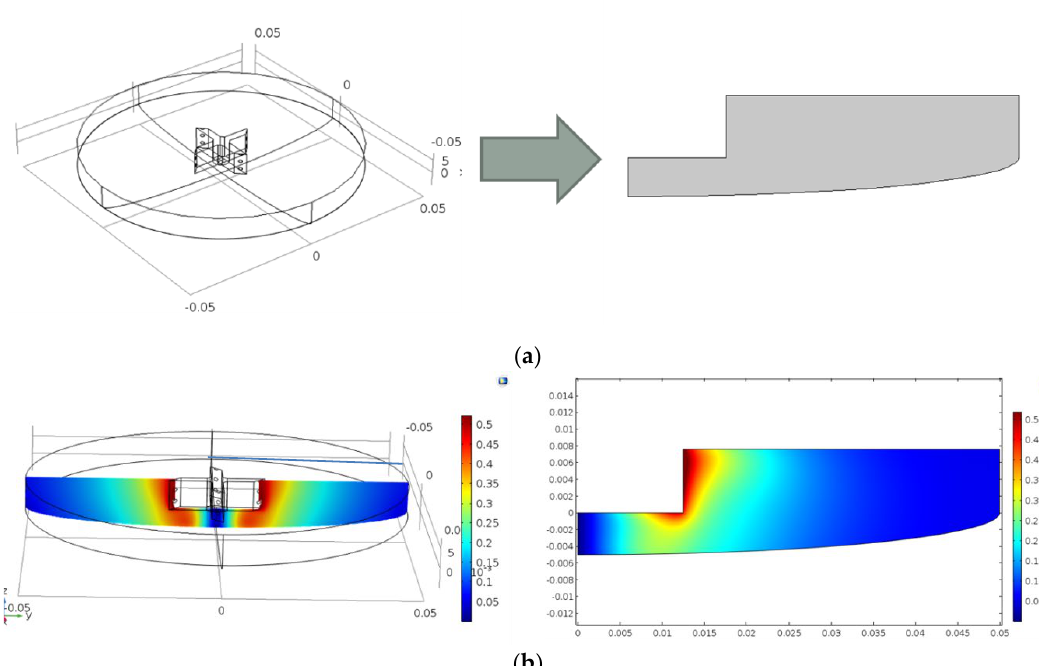
Figure 1. ( a ) The 3D and 2D representation of the reactor; ( b ) the velocity field results in the case of 3D and 2D simulation.